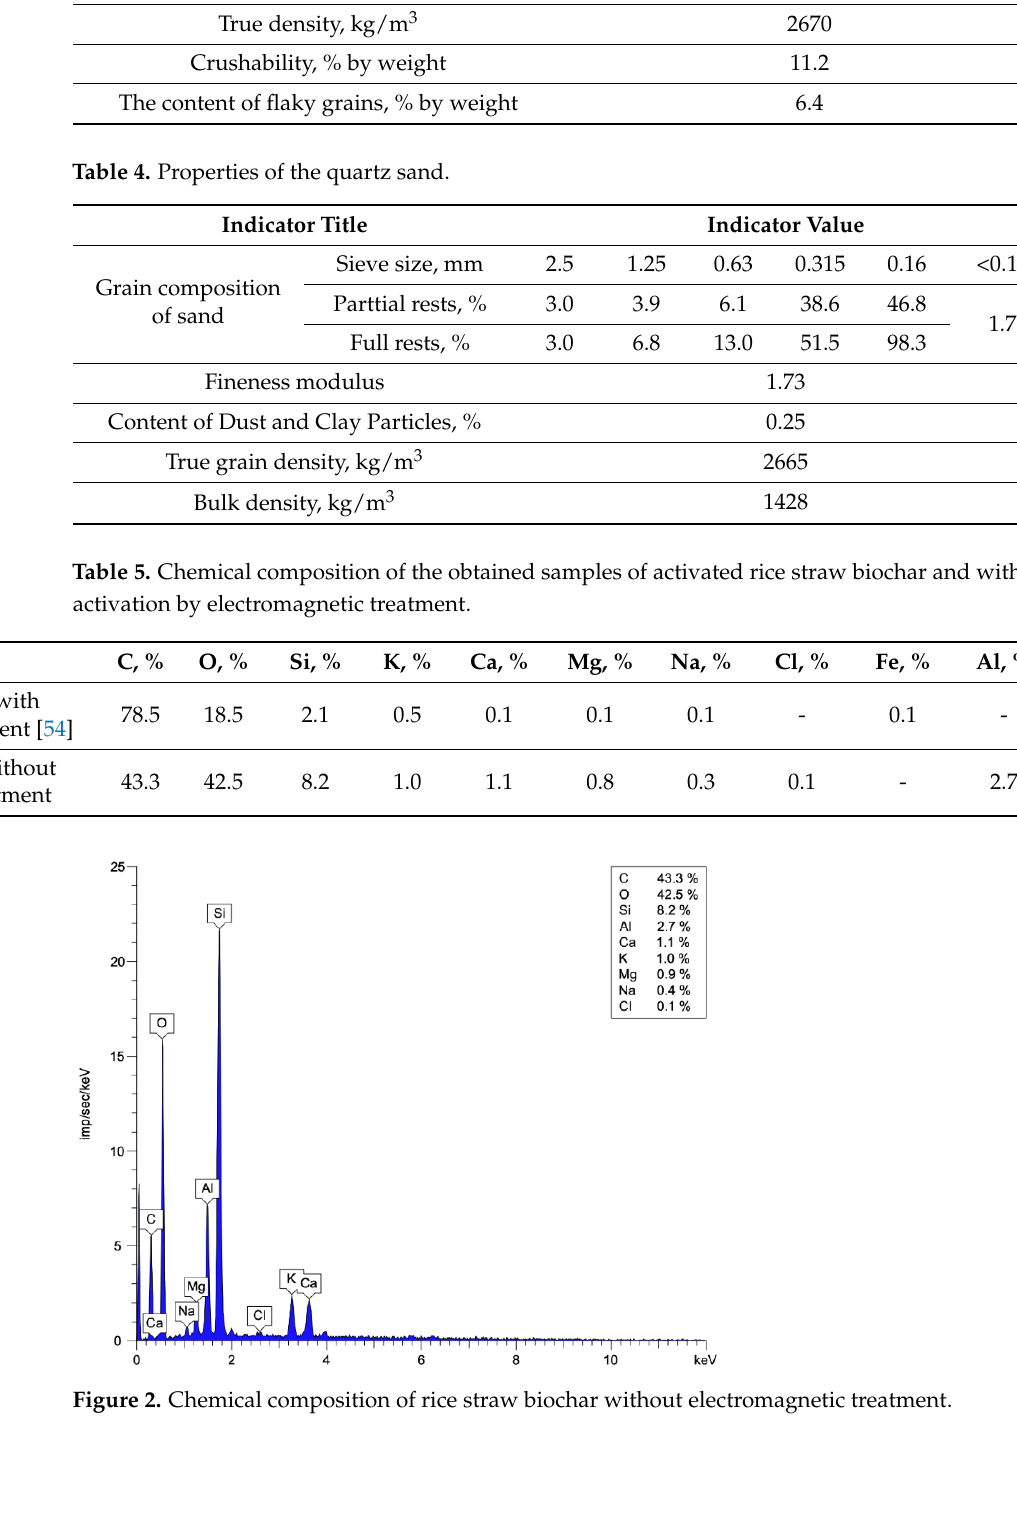
Table 4. Properties of the quartz sand.